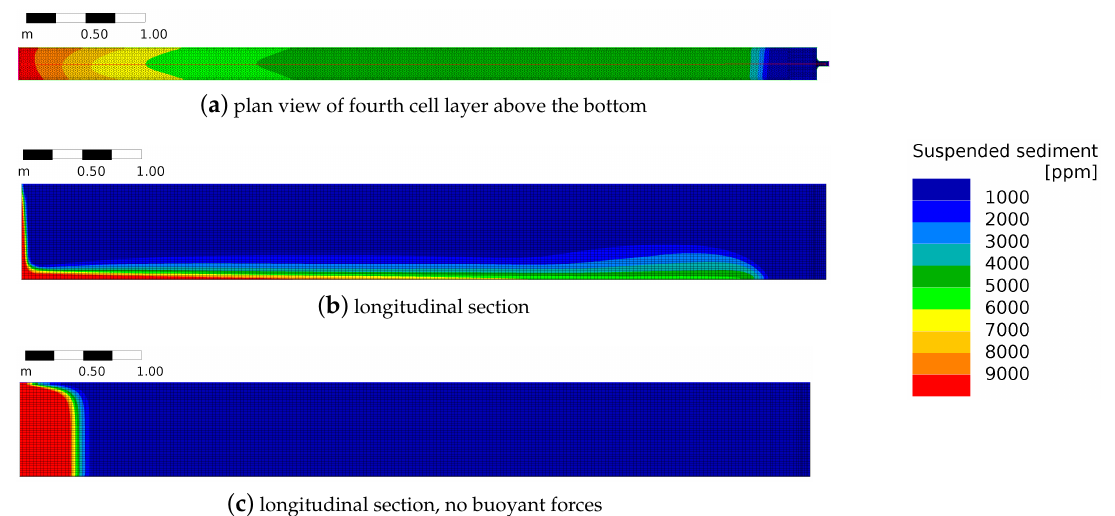
Figure 5. Sediment concentration contours in ppm at the start of venting ( t = 150s, maximum concentration: 23,000